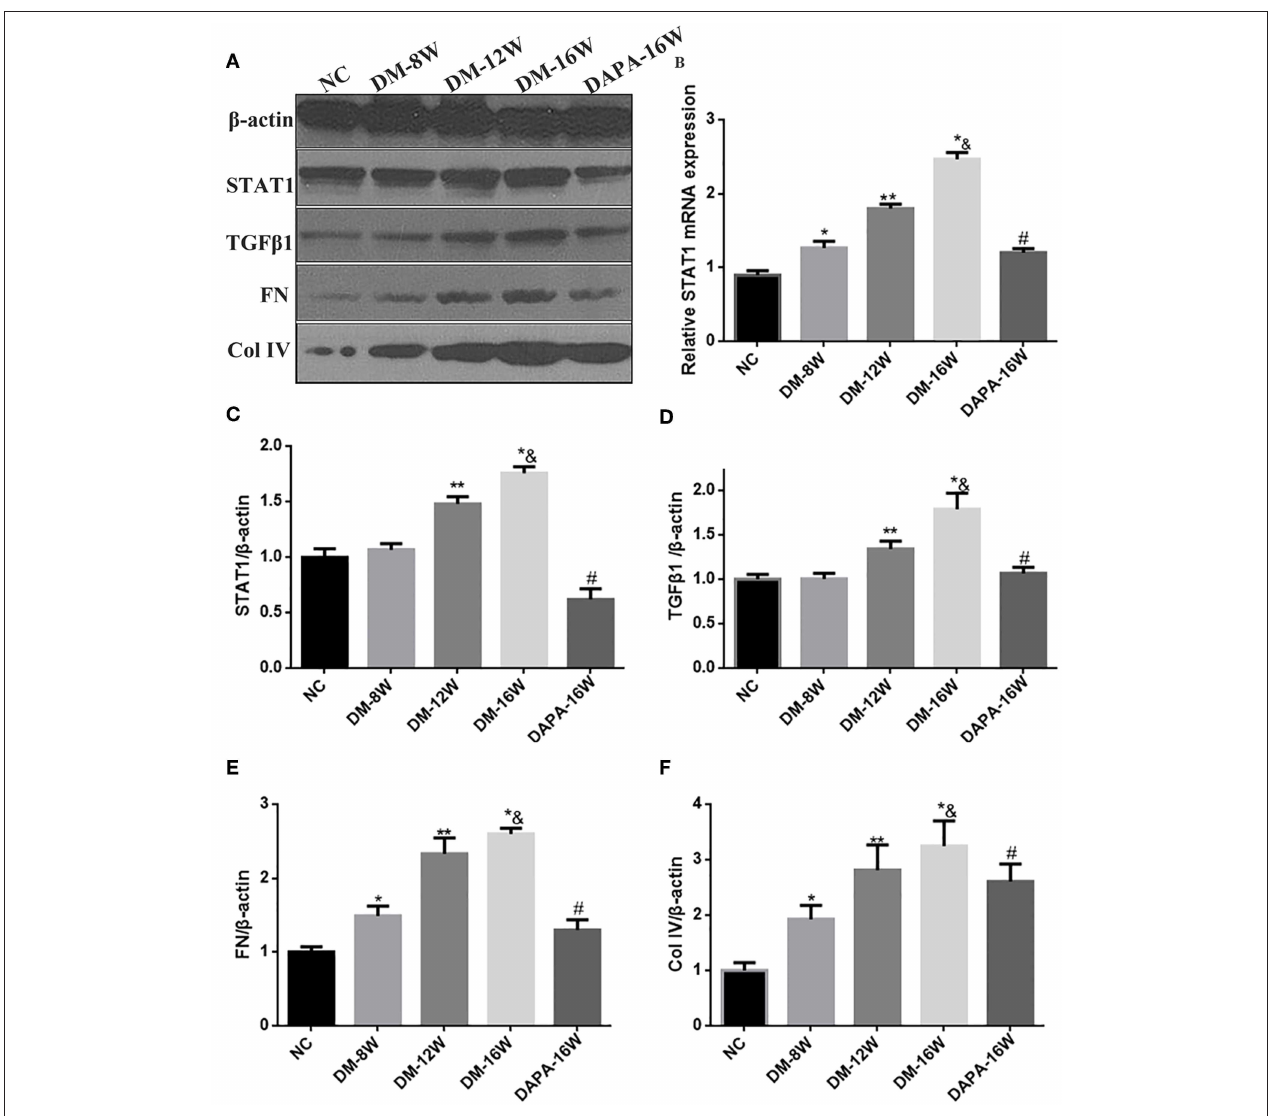
FIGURE 3 | Effect of DAPA on renal production of fibrotic markers in diabetic mice. (A) Representative western blots for STAT1, TGF- β 1, Col IV, and FN in renal cortical lysates. β -actin was used as internal control. (B) Density ratio of STAT1 to GAPDH mRNA expressions. (C–F) Normalized quantification of western blot data in diabetic mice at different times. * P < 0.05 vs. NC; ** P < 0.05 vs. DM-8W; * & P < 0.05 vs. DM-12W; # P < 0.05 vs. DM-16W. Values are means ± SEM. n = 3.